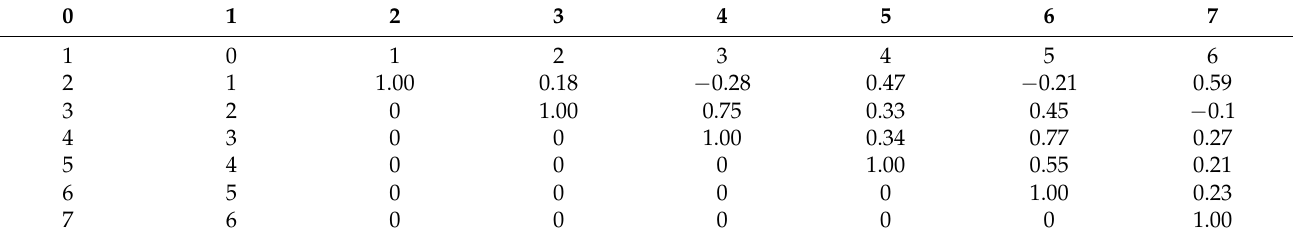
( 1 ) ( i ) ; ν ,i = 1.7 (preceding crop—maize). 1 ν